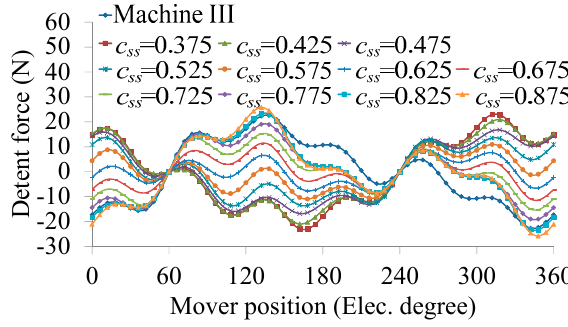
Figure 13. Detent force waveforms with different c ss . Table 1. Side-slot width and machine active length with different c ss .